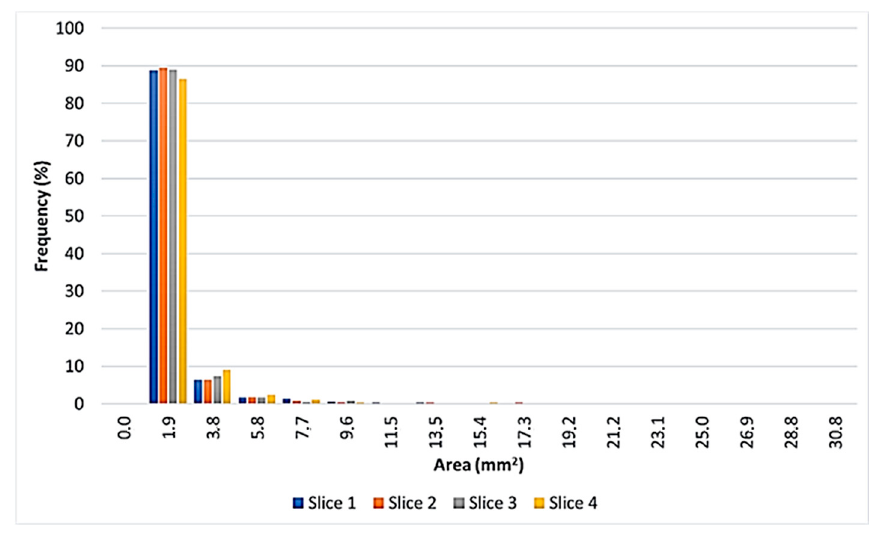
Figure 7. Distribution of cell size.